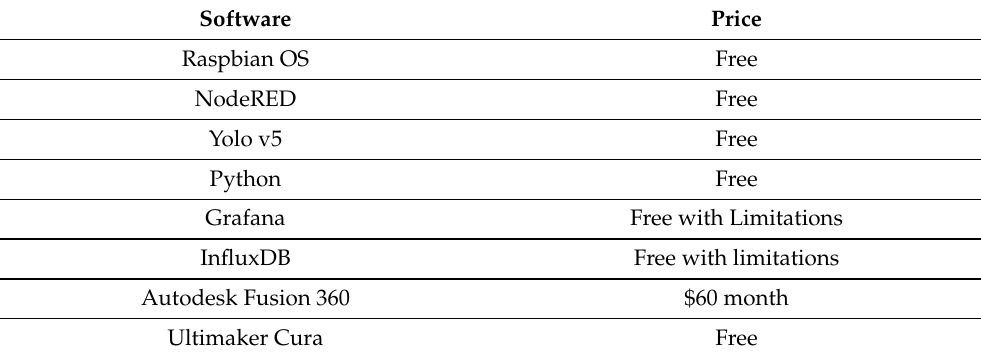
Table 3. List of software and tools needed to run the functionalities in the platform.